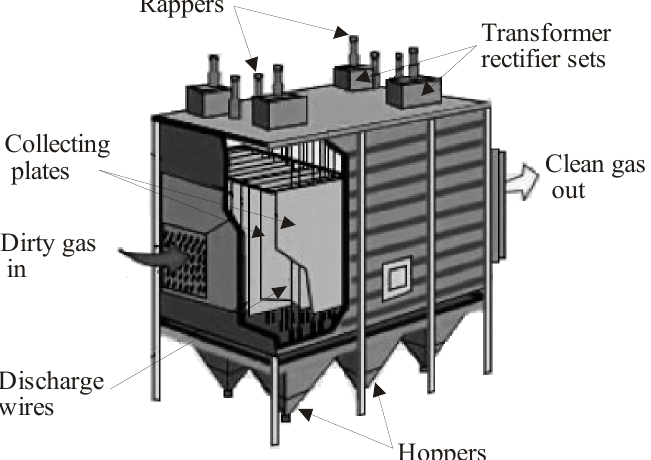
Figure 2. Industrial ESP with three sections (typical configuration) [10].